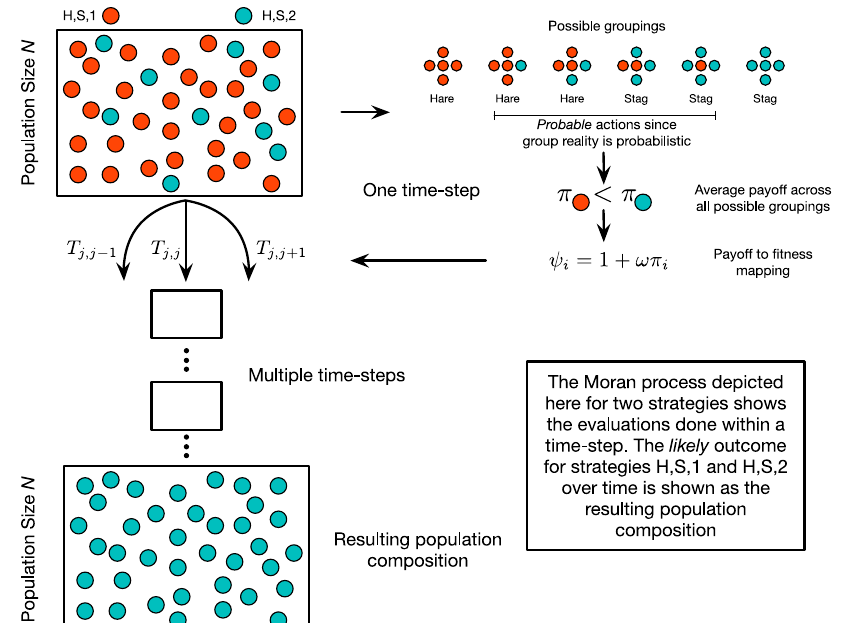
Fig. 4 Transitions in a fi nite population. In this fi gure, we highlight the transitions in a population of size N predominantly made up of (H,S,1) individuals and a small number of (H,S,2). For the sake of simplicity we have illustrated here an example with only two types. Mutations (here only between these two types) are incorporated in the transition probabilities. The groupings will typically consist of a majority of (H,S,1) resulting in narrative 1 as the group belief and hare hunting. The average payoff of a (H,S,2) individual is slightly larger than that of a (H,S,1) individual: although most groups will choose narrative 1, resulting in hare hunting, narrative 2 is occasionally chosen by those groups that contain (H,S,2) members, and such groups access the higher stag payoff. Over time this can result in (H,S,2) taking over the population. In general, multiple phenotypes can exist simultaneously following the same selection rule. In such cases there are fi fty seven transition probabilities and mutations are possible between all the strategies. This can lead to a coexistence of multiple strategies as shown. Such eventual coexistence through a tumultuous transient phase can be seen in the Fig.